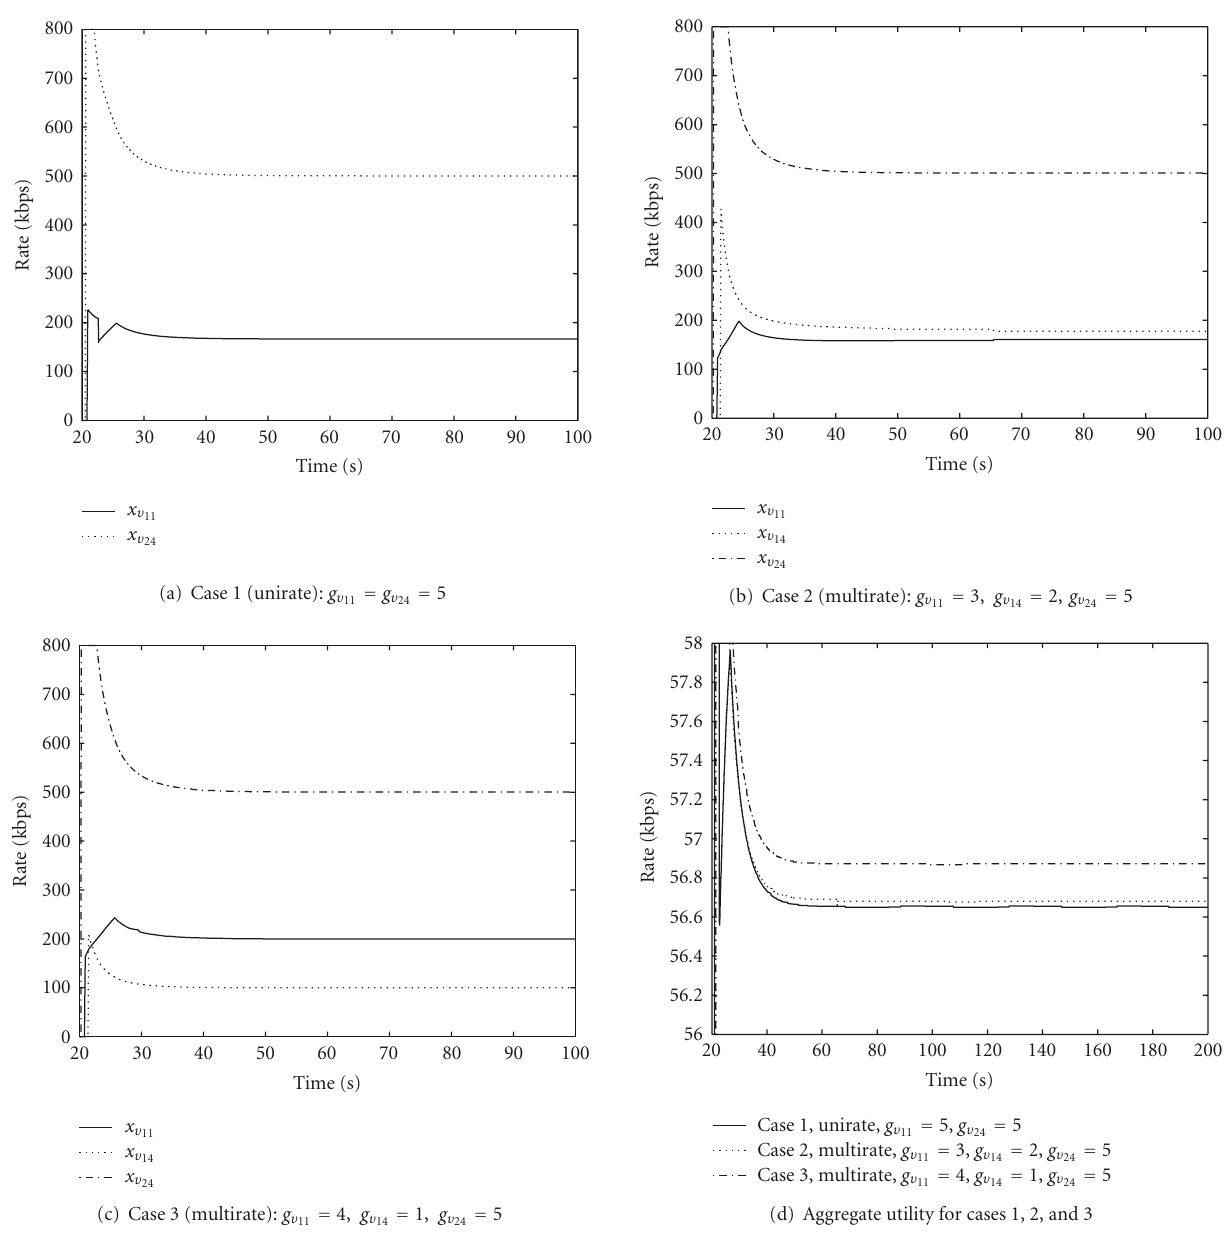
Figure 9: E ff ect of changing di ff erentiation gains on the calculated rates and aggregate